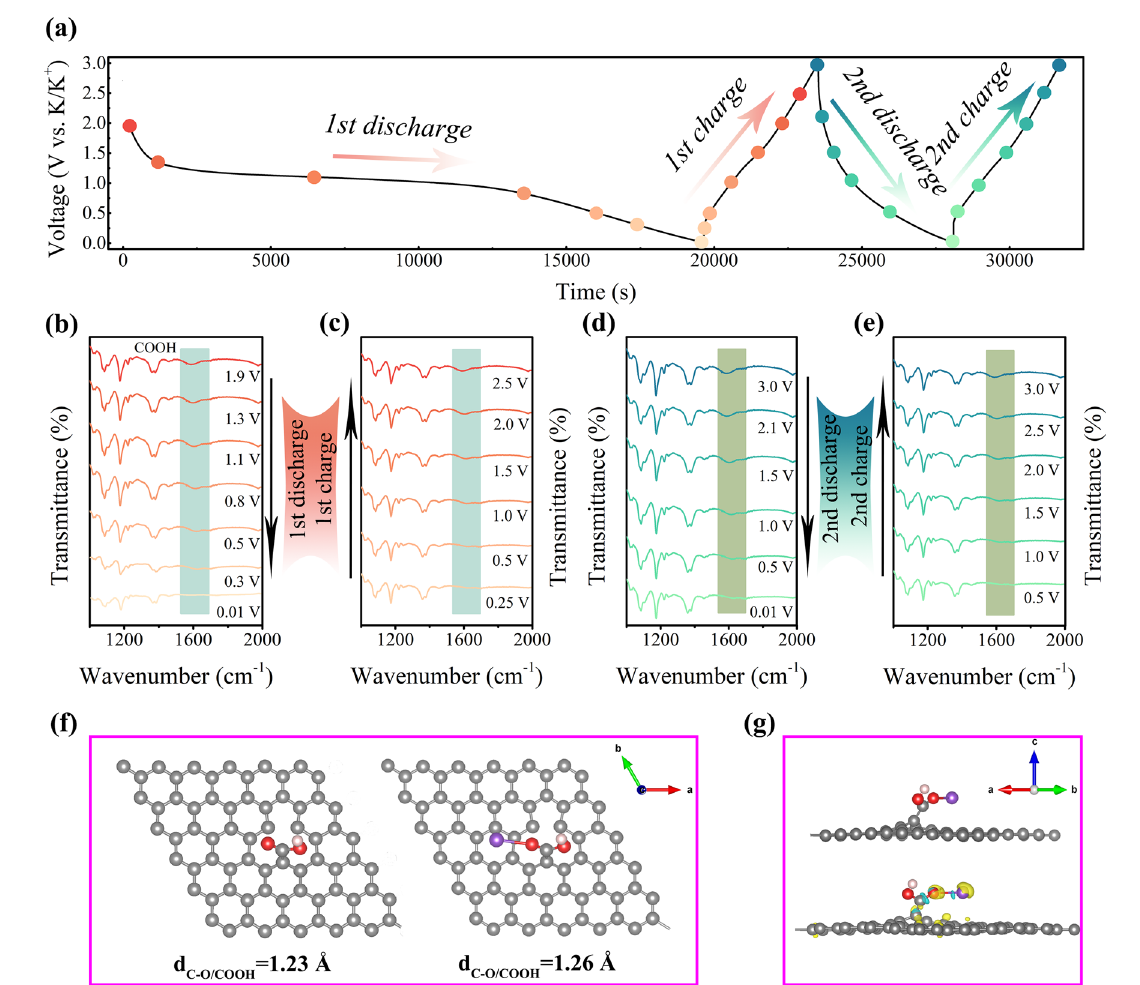
Fig. 4 Analysis of potassium storage mechanism. a Galvanostatic charge/discharge profile of OFGC-600 during the in situ FT-IR measure- ment. b - e FT-IR spectra of OFGC-600 at different potentials during galvanostatic charge/discharge processes. f The optimized configurations of a single K atom adsorbed in graphene with COOH functional groups and g the charge density of graphene with COOH functional groups after adsorbing K ion. Yellow and blue areas represent increased and decreased electron density,